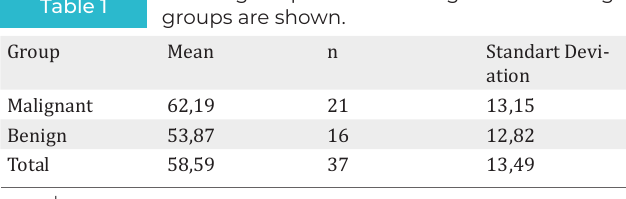
Mean age of patients in malignant and benign groups are